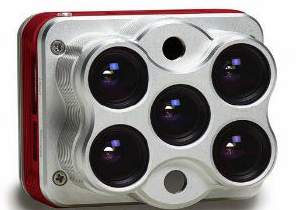
Figure 3: Micasense Altum Combined Multispectral and Thermal